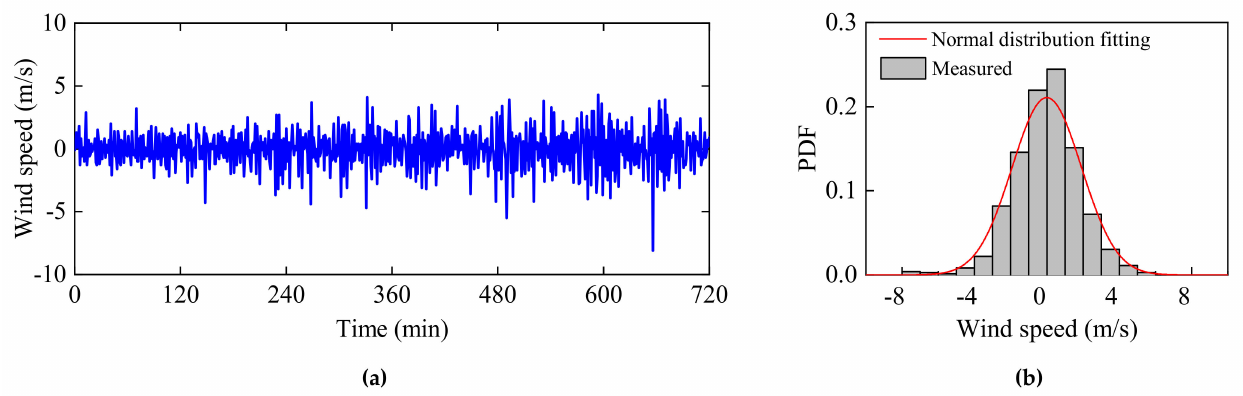
Figure 5. Differenced dataset. ( a ) Data obtained after first-order difference; ( b ) PDF of differenced dataset.